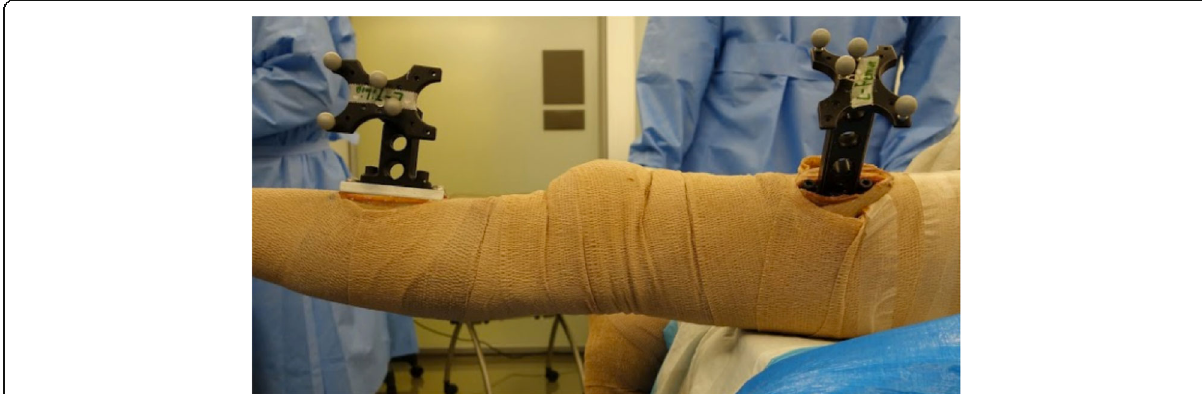
Fig. 1 Photograph demonstrating the arrays of reflective markers used for infrared motion capture analysis, which are fixed to the femur (right) and the tibia (left) using a combination of screw fixation and bone cement